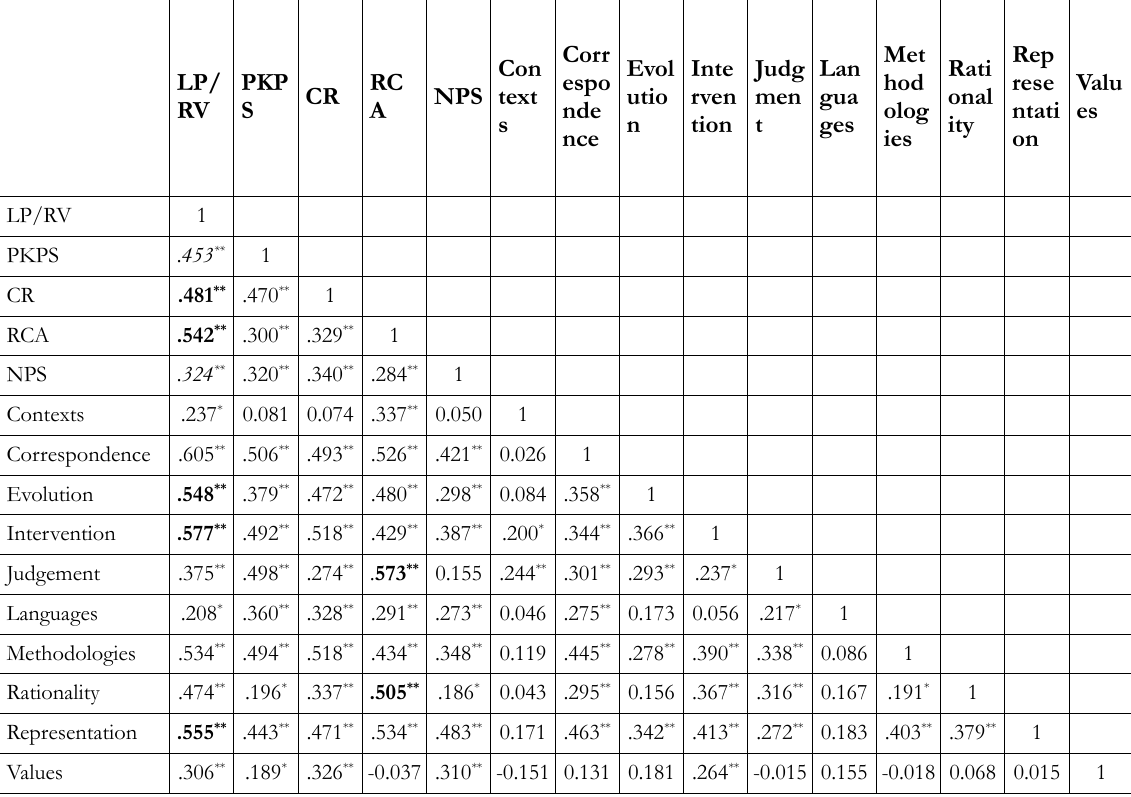
Table 4. Correlations between periods and